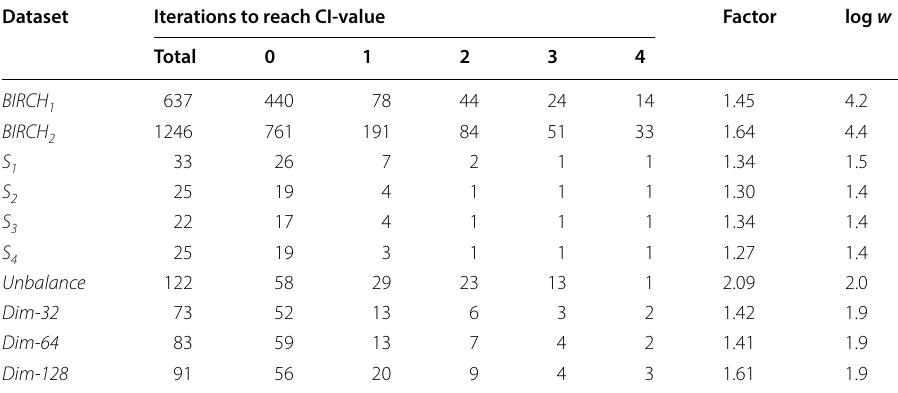
Table 5 Total number of iterations required to reach a solution with certain number of swaps remaining (0–4)